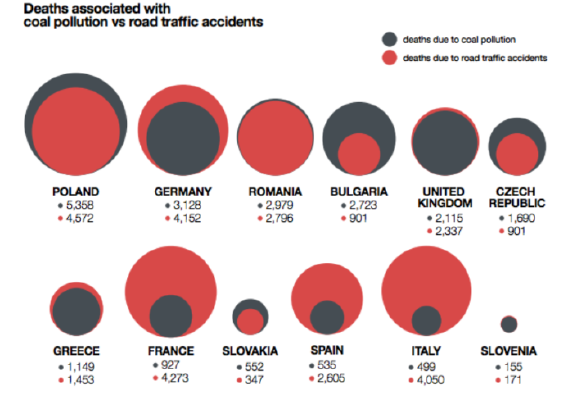
Figure 1. Coal pollution vs Road traffic accidents in EU [source